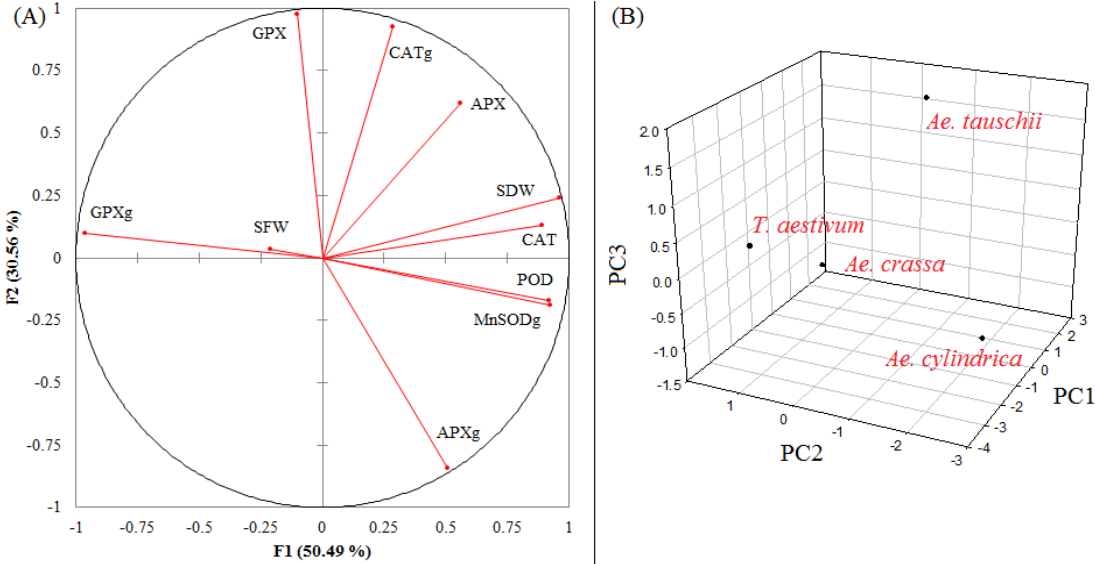
Figure 3. ( A ) Biplot rendered by the first two components to show associations among the measured characteristics. ( B ) A PCA-based 3D plot indicates the separation of the investigated accessions based on their factor loadings. SFB, shoot fresh biomass (g plant −1 ); SDB, shoot dry biomass (g plant −1 ); APX, ascorbate peroxidase (U mL −1 ); POD, peroxidase (U mL −1 ); CAT, catalase (U mL −1 ); GPX, guaiacol peroxidase (U mL −1 ); APXg , APX gene; MnSODg , MnSOD gene; GPXg , GPX gene; CATg , CAT gene.